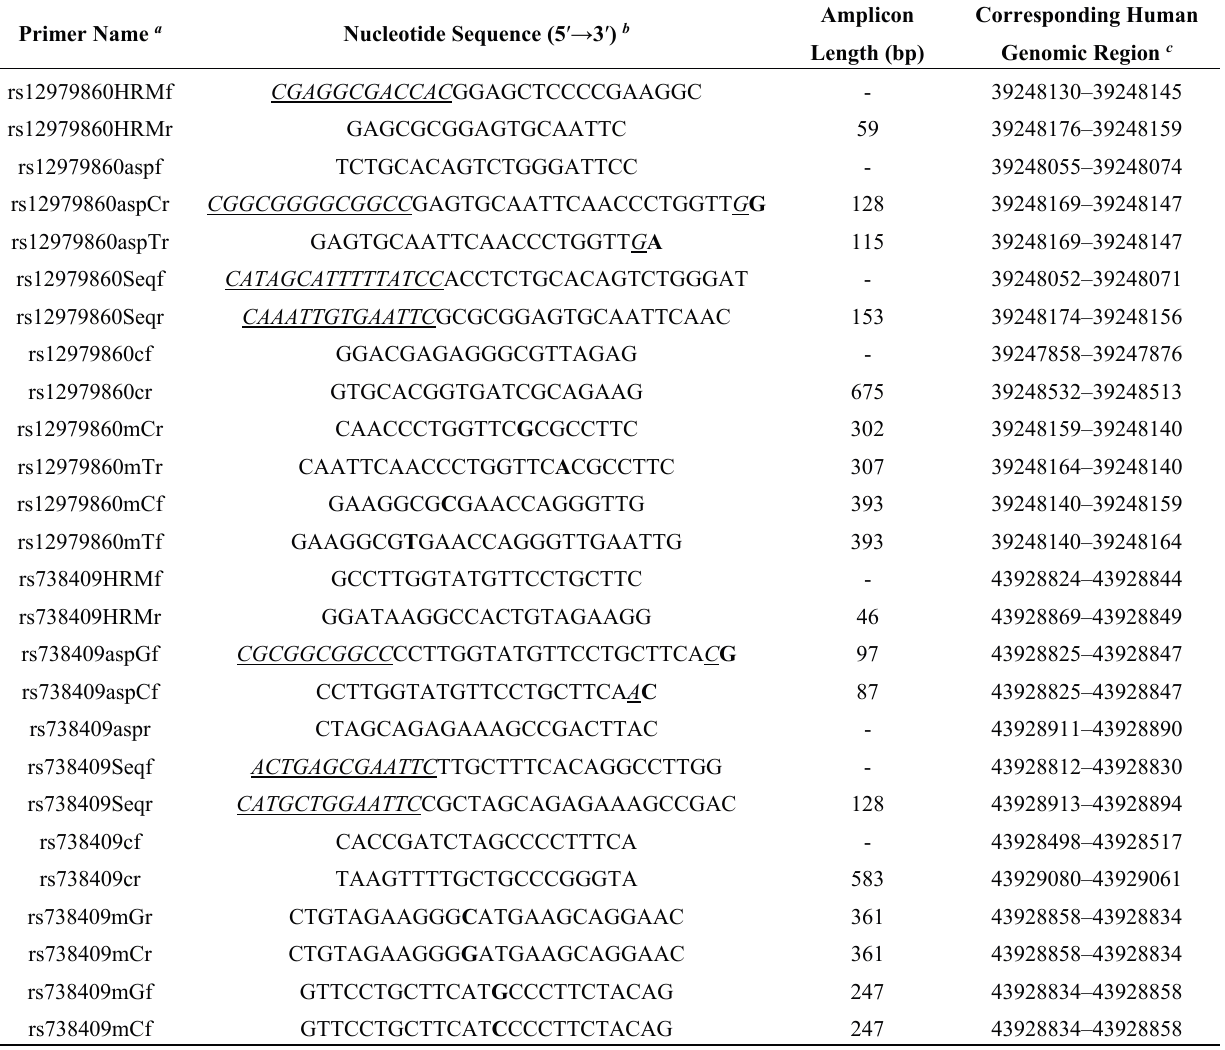
Table 3. Primer sequences for HRM assays, allele-specific PCR, Sanger sequencing, and